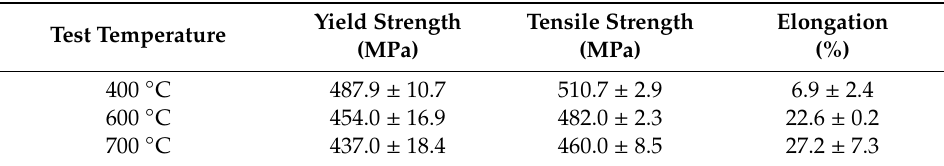
Figure 1. The results of electron backscatter di ff raction (EBSD) analysis for DFW: ( a ) inverse pole figure (IPF) map and ( b ) grain boundary character, where blue, green, and red lines indicate high misorientation angle boundaries (15 ◦ ≤ θ < 180 ◦ ) and low misorientation angle boundaries (5 ◦ ≤ θ < 15 ◦ , 2 ◦ ≤ θ < 5 ◦ ), respectively. (Gray spots in ( b ) are residue of colloidal silica used in polishing.). Table 2. Tensile properties of DFW rod.